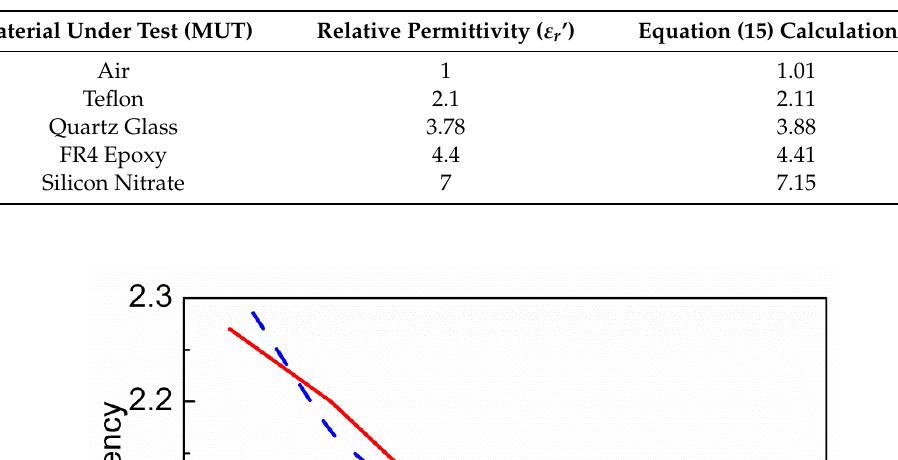
Table 4. Relative permittivity evaluation using measured result.